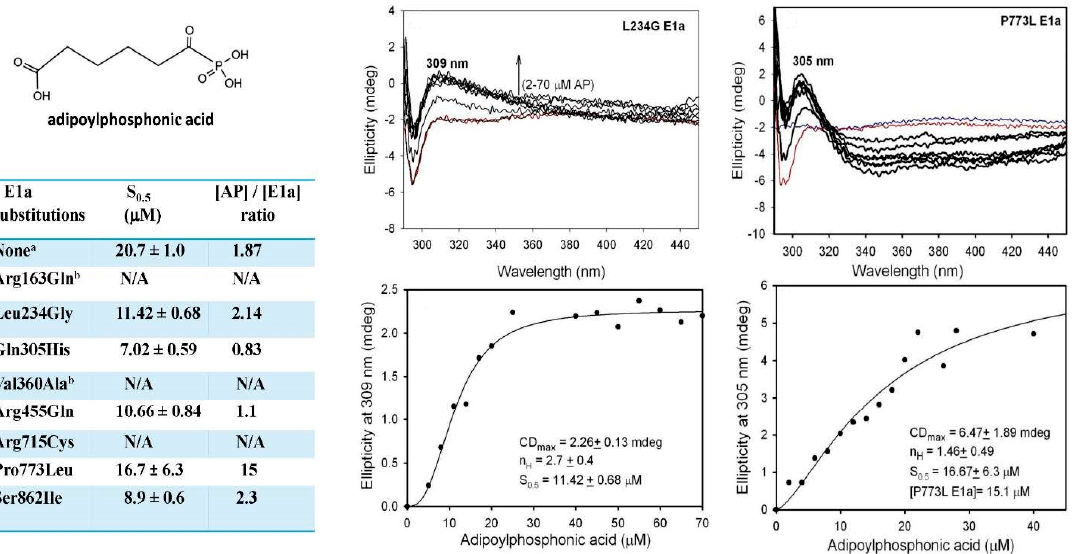
Figure 5. Formation of 1 ′ ,4 ′ –iminophosphonoadipoyl-ThDP pre-decarboxylation intermediate on binding of adipoylphosphonic acid (AP) in the active centers of E1a variants. a Data for WT E1a are from [16]. b The Arg163Gln and Val360Ala E1a variants were partially precipitated under conditions of experiment. N/A, not available.